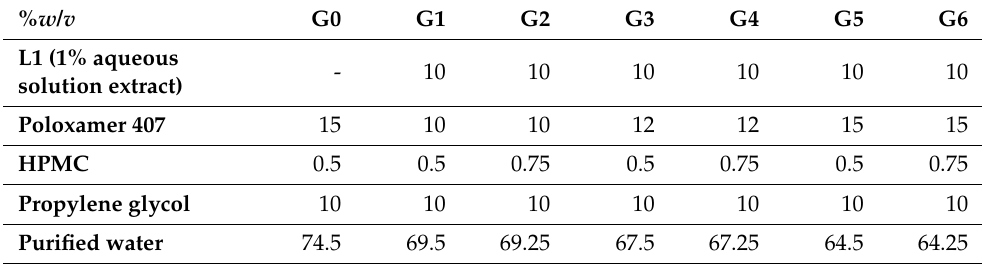
Table 4. Ophthalmic in situ gel compositions, with balsam poplar buds extract. % w /